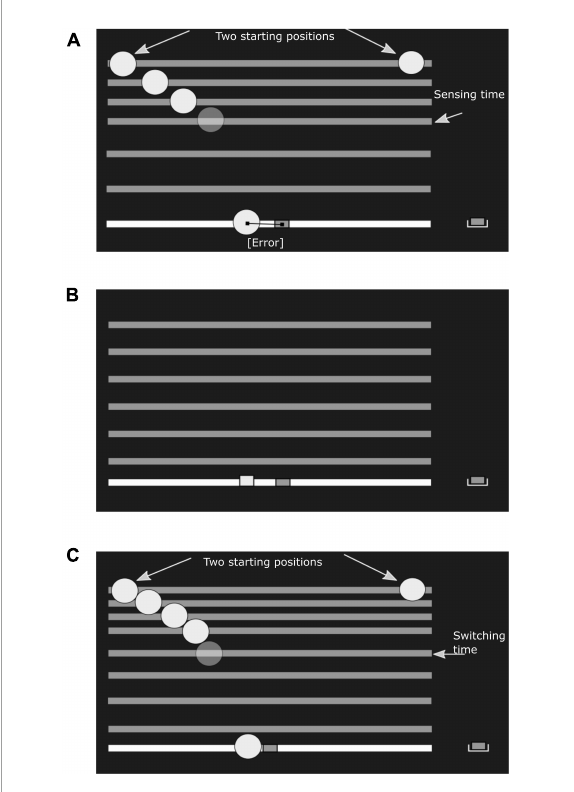
FIGURE1 Experimental conditions. In the experiment the ball was drawn in green and the paddle in red. Ground level, the falling bar and the paddle start location were white. (A) Sensory task: The subject would see a ball falling, with a constant horizontal velocity and under simulated gravity, from either the left or right start position (fixed within a session). The horizontal bar would fall along with the ball. After a pre-determined sensing time, the ball disappeared, but the bar kept falling. After the bar hit ground level, the subject had infinite time to indicate the estimated landing position, using the paddle. (B) Motor task: A reach target is shown as a small red square at ground level. The required movement time is first indicated by a bar falling at constant velocity. Next, the subject has to reach from the start position to the target within the prescribed movement time, again with the bar falling as an indicator of remaining time. (C) Combined task: The ball falls from either the left or right start position (fixed within a session). The ball disappears once the subject starts moving the paddle, defining the ‘switching time’. The bar continues to fall to function as a timer. The task of the subject is to catch the ball on the paddle before it hits ground level. In all conditions the subject receives feedback about the final paddle position relative to the true landing position of the ball (A,C) or reach target (B)